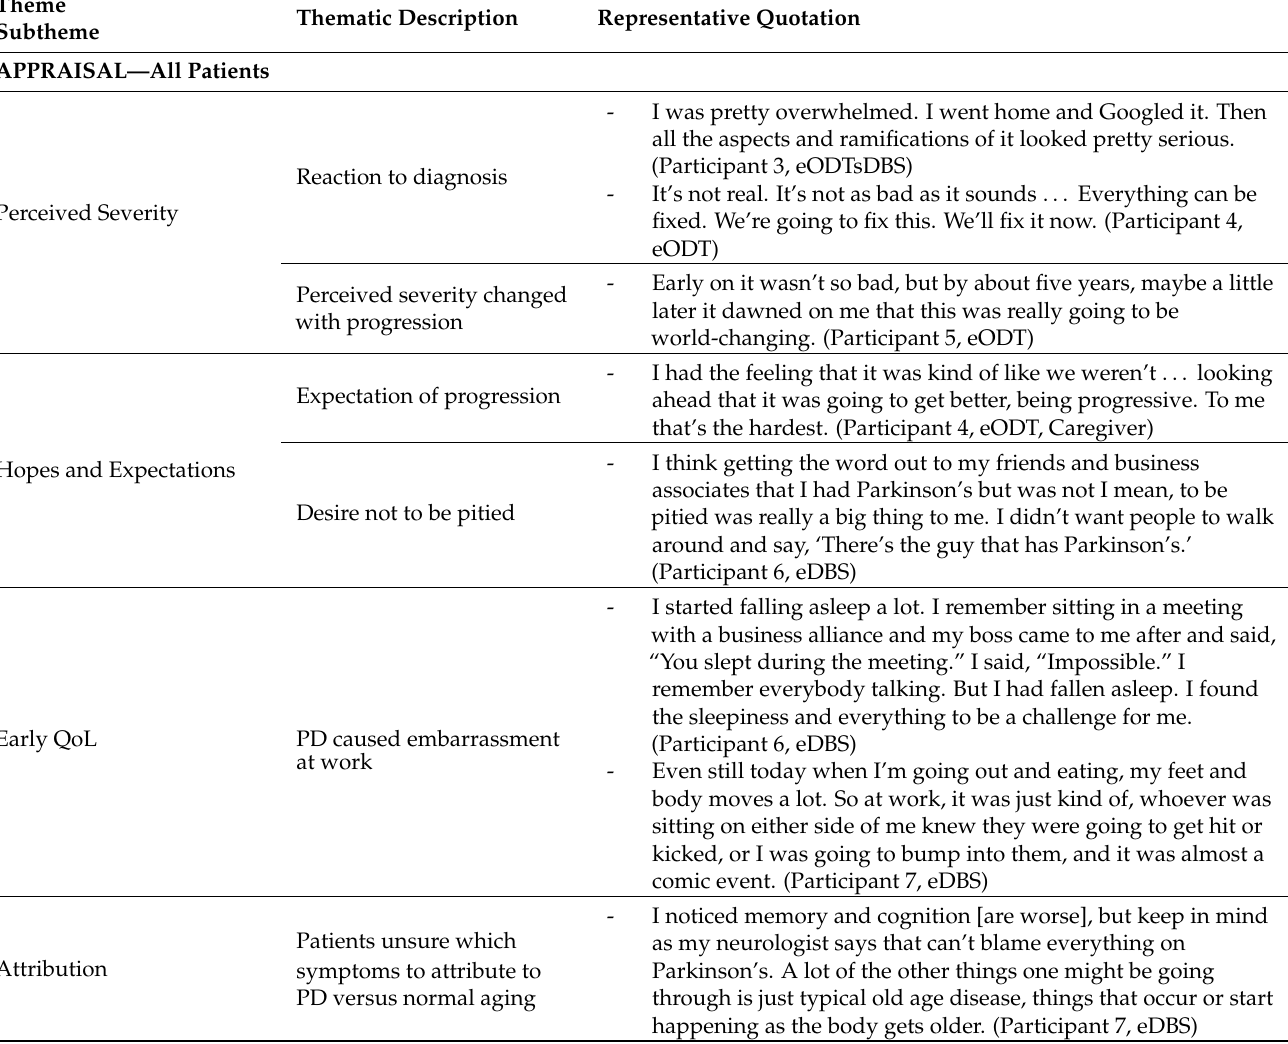
Table 3. Thematic factors and representative quotations significant in eleven-year PD